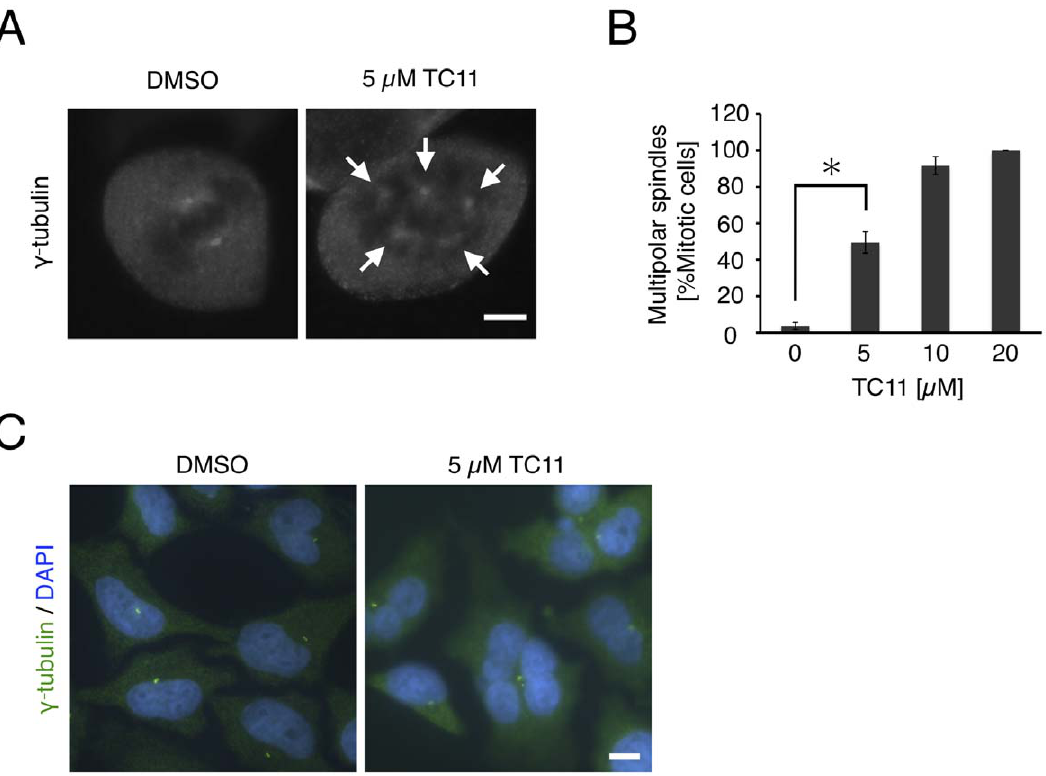
Figure 6. TC11 increases spindle multipolarity, resulting in multinucleation. HeLa cells were treated with 0–20 m M TC11 for 6 h. Then, immunofluorescence staining of c -tubulin was performed. (A) Representative mitotic cell under the indicated conditions. (B) Mitotic cells with multipolar spindles were counted under the indicated conditions. At least 100 mitotic cells were counted per sample in three independent experiments. An asterisk denotes a statistically significant difference according to Student’s t -test (P , 0.05). White arrows indicate centrosomes. (C) HeLa cells were treated with 5 m M TC11 for 24 h, followed by immunofluorescence staining with anti- c -tubulin antibody (green). Nucleus was stained with DAPI (blue). Bar; 10 m m.